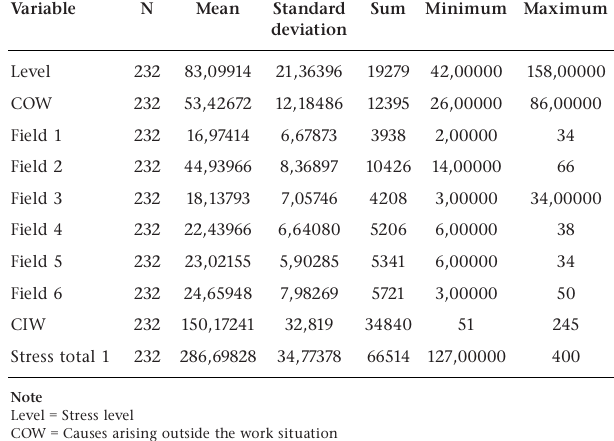
Table 2 indicates that the highest mean score of 2,00 was obtained for the variable SQ2, with a standard deviation of